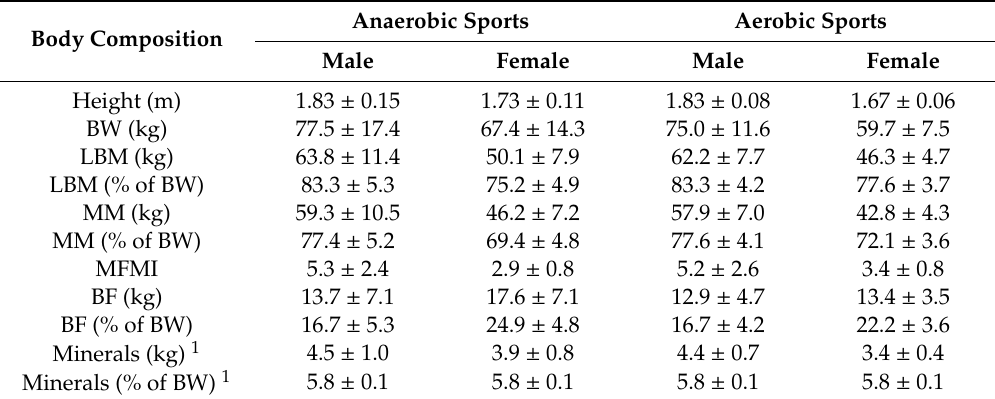
Table 2. Body composition of athletes (by sport and gender). Body